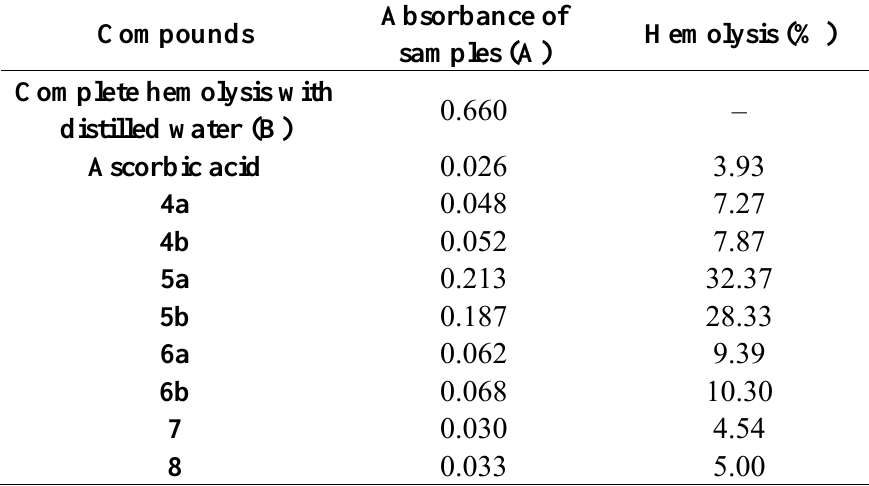
Table 2. Anti-oxidant assays by erythrocyte hemolysis (A/B × 100).